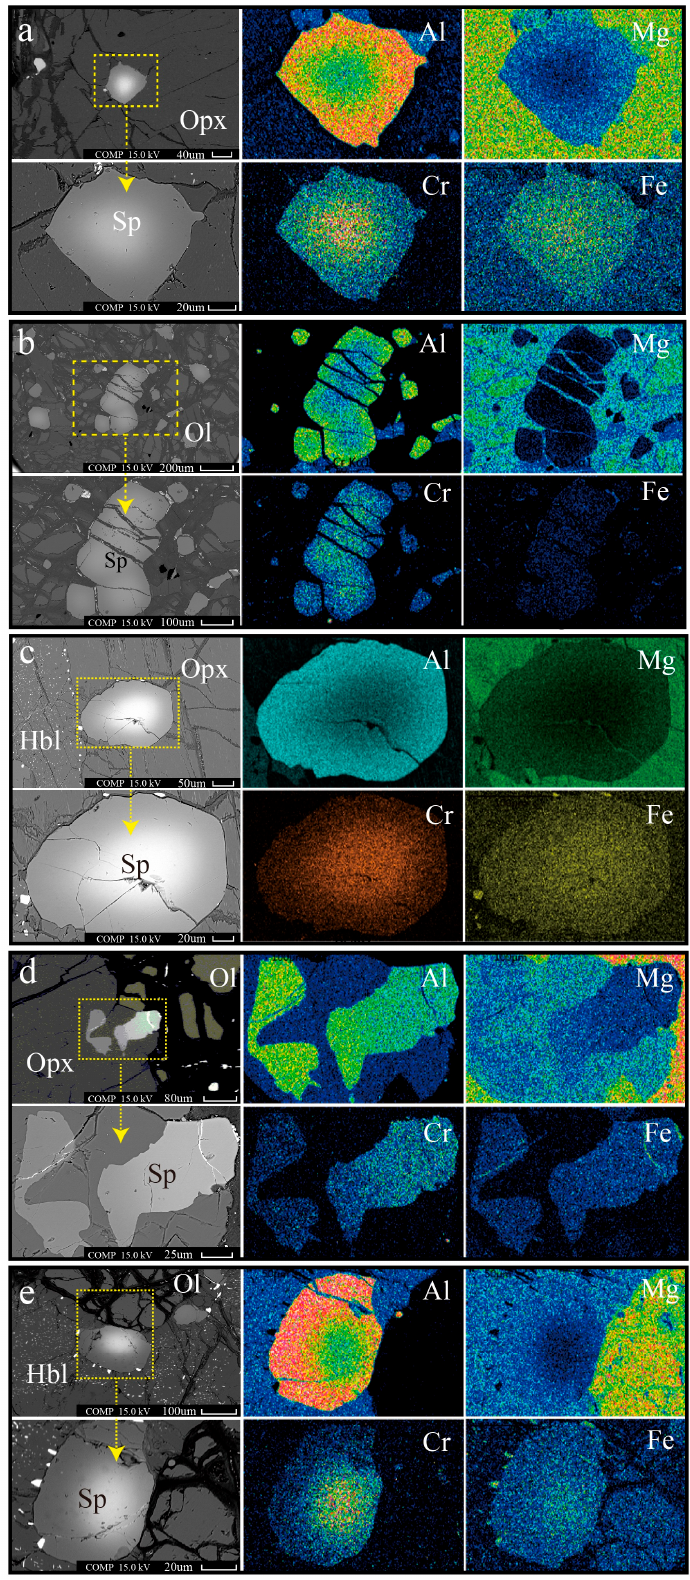
3 Figure 4. Elemental mapping images of zoned Cr-spinel (Sp): ( a ) Zoned Cr-spinel surrounded by enstatite (Opx); ( b ) Cr-spinel cluster enclosed in olivine (Ol); ( c ) Interstitial zoned Cr-spinel located between tschermakite (Hbl) and enstatite (Opx) ( d ) Interstitial zoned Cr-spinels located between olivine and enstatite; ( e ) Interstitial zoned Cr-spinel located between olivine and